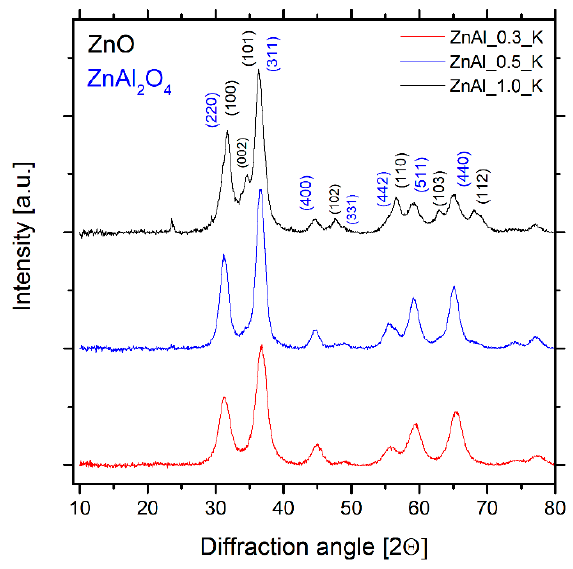
Figure 2. XRD patterns of fresh ZnAl_X_K catalysts.